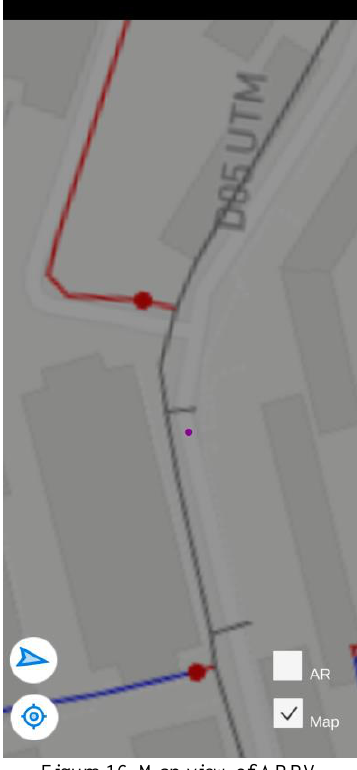
Figure 16. Map view of